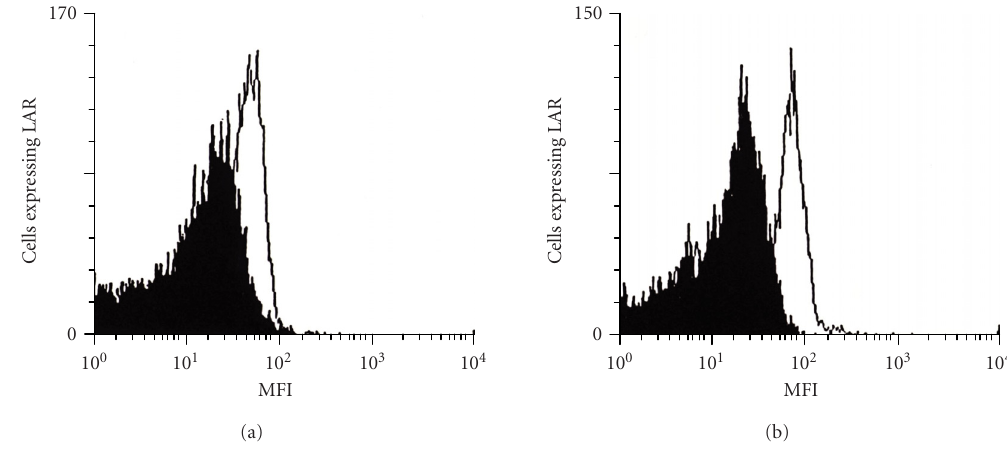
Figure 1. Flow cytometric histogram profiles of LAR expression in (a) unfixed human umbilical vein endothelial cells (HUVEC) and (b) fixed HUVEC. The shaded profile represents the expression obtained with the isotype control antibody, anti-KLH, and the open profile represents the expression with an anti-LAR antibody. These results are representative of three experiments. MFI denotes mean flurescence